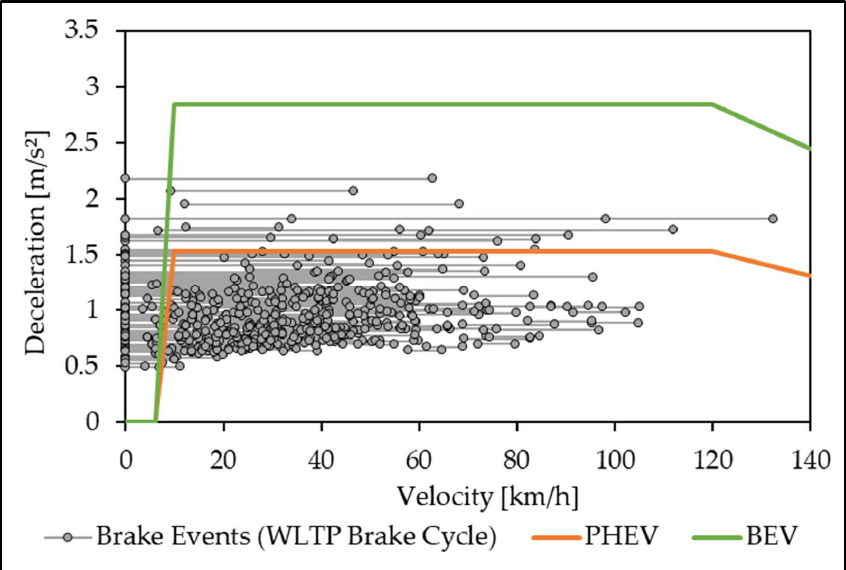
Figure 2. Recuperation map for the simulation of PHEV and BEV. Brake events inside the respective curve are performed purely electric. Those crossing or outside the curve include brake blending or complete takeover by the friction brake, respectively.